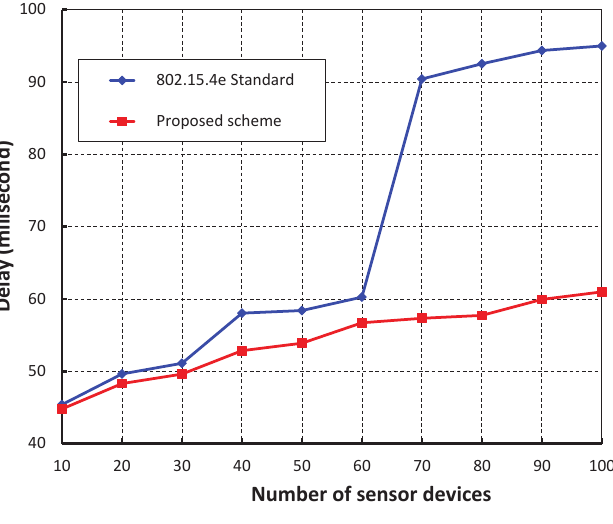
Figure 13. Comparison of packet delay of our scheme with IEEE 802.15.4e standard.